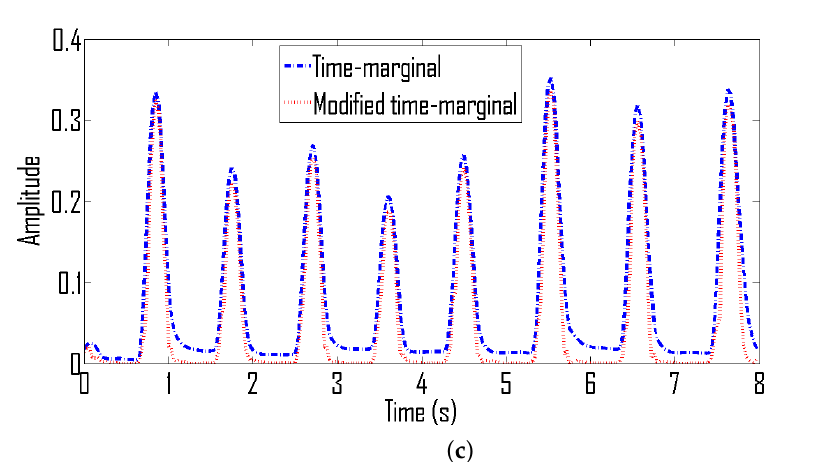
( t , f ) of the EEG seizure signal, t